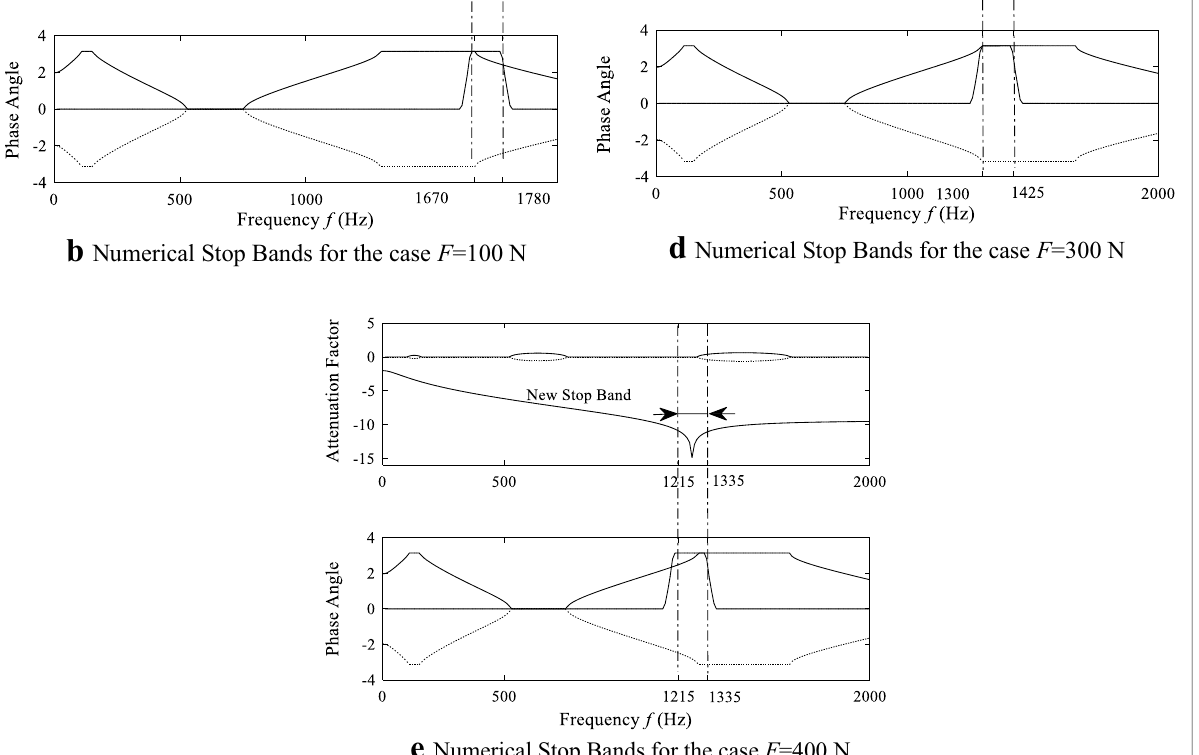
Figure 3 Numerical Stop Bands deduced at different axial